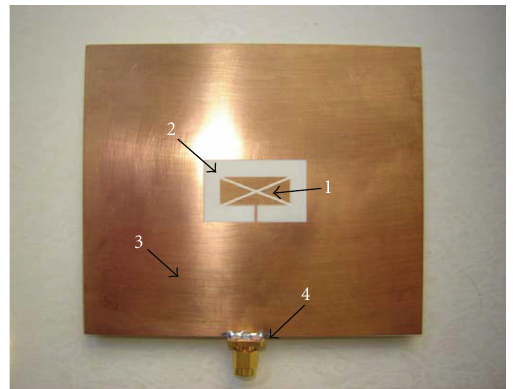
Figure 2: Photograph of the antenna: (1) cross-slot; (2) square slot; (3) ground plane; (4) input port is connected to microstrip line.